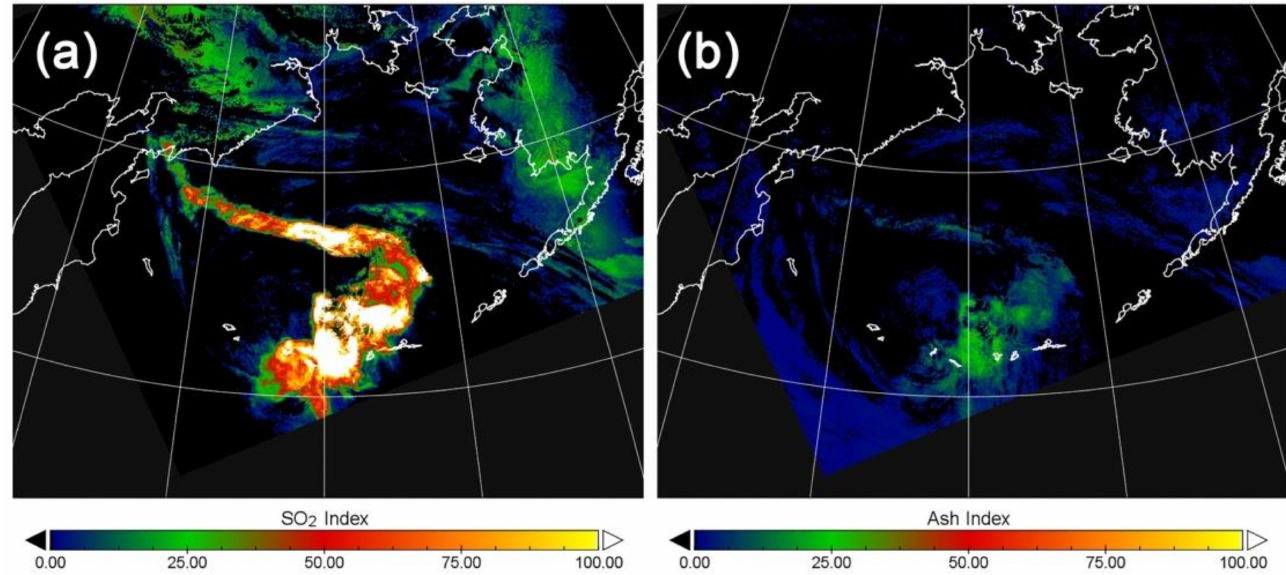
Figure 5. The VIIRS ( a ) SO 2 and ( b ) Ash Index maps for the 2019 Raikoke (Kurile Islands) eruption clouds on 24 June 2019. As demonstrated by these Raikoke maps, our scaling and visualization strategies capture all but the strongest absorption without saturating while also delineating subtle plumes with weaker